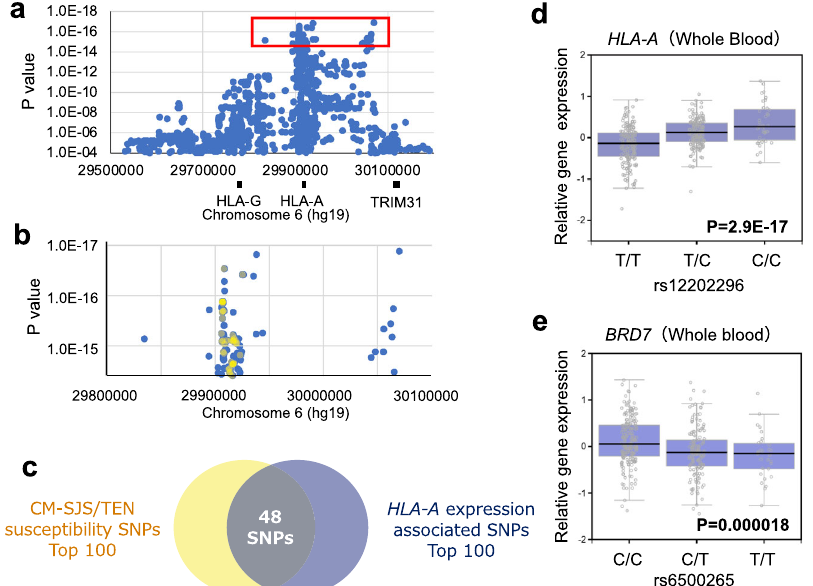
Fig. 3 CM-SJS/TEN with SOC-susceptibility polymorphisms in HLA-A and chromosome 16q12.1 are associated with gene expression levels in a cis manner. a The association of polymorphisms in the HLA-A locus with the endogenous expression levels of HLA-A . Blue dots inside the red rectangle show the 100 SNPs with the strongest association with endogenous expression levels of HLA-A in whole blood. b , c Partial coincidence between the 100 SNPs with the strongest association with susceptibility to CM-SJS/TEN with SOC (dots shown in yellow) and that with endogenous expression levels of HLA-A in whole blood (dots shown in blue). d Signi fi cant association between rs12202296 and the expression level of HLA-A in whole blood. CM-SJS/TEN with SOC-susceptibility allele rs12202296 is denoted as the C allele. e Signi fi